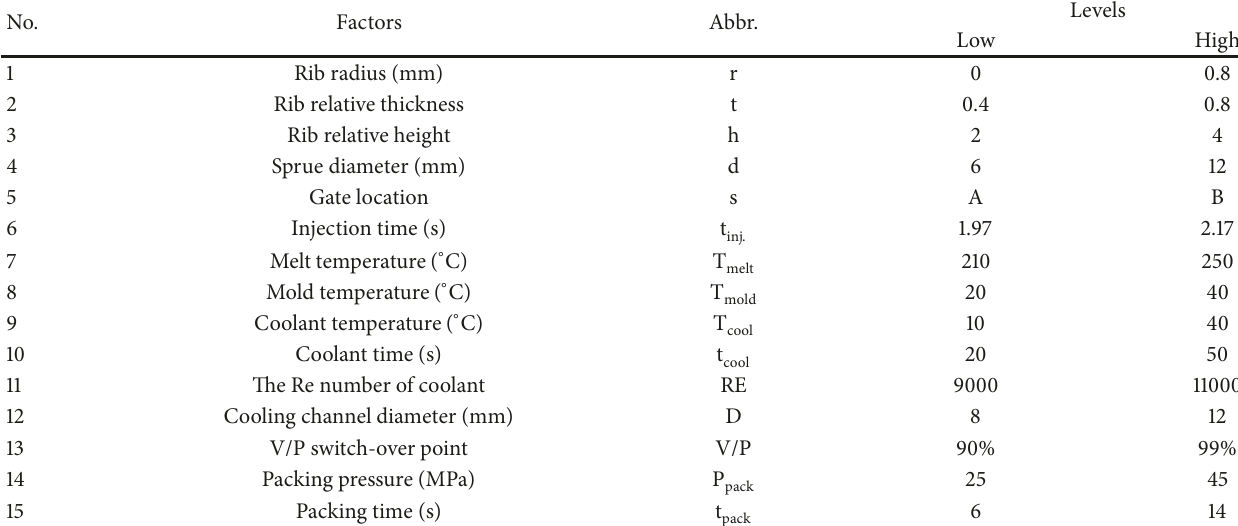
Table 2: Experimental factors and their levels.